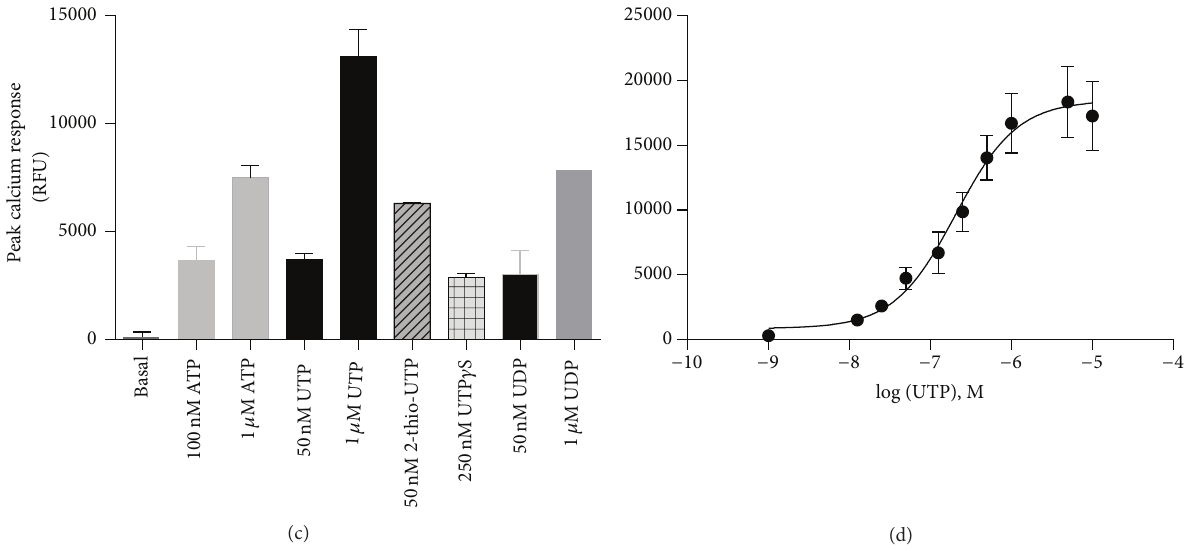
Figure 1: Nucleotides induce intracellular calcium responses in THP-1 cells. (a) Representative plot showing P2Y2 expression on THP-1 monocytes using a specific anti-P2Y2 antibody and a BD FACSCalibur flow cytometer. (b) THP-1 cells were loaded with Fluo-4 using a NW kit and plated at 2 × 10 5 cells/well in poly-D-lysine coated 96-well plates. Intracellular calcium responses were measured using a BMG Labtech Fluostar Optima plate reader for over 60 seconds at 37 ∘ C. Responses to 100nM ATP, 50 nM UTP, 50 nM 2-thio-UTP, and 250 nM UTP 𝛾 S are shown in black. Paired responses of cells pretreated with the P2 receptor antagonist suramin (30 𝜇 M; 30 minutes) are shown in red. (c) Mean calcium response data from several experiments. (d) A concentration-response curve was generated for UTP-induced calcium responses on THP-1 cells. Mean responses ± SEM are plotted from 4 separate